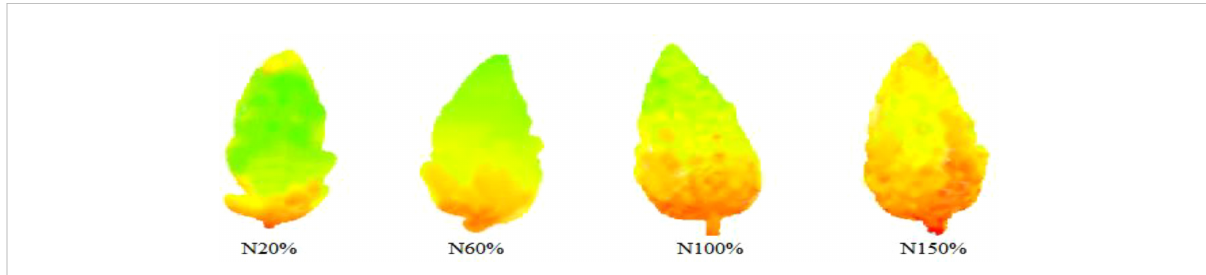
FIGURE 14 THz images of leaves with different nitrogen levels in the characteristic frequency bands screened by the iPLS algorithm.